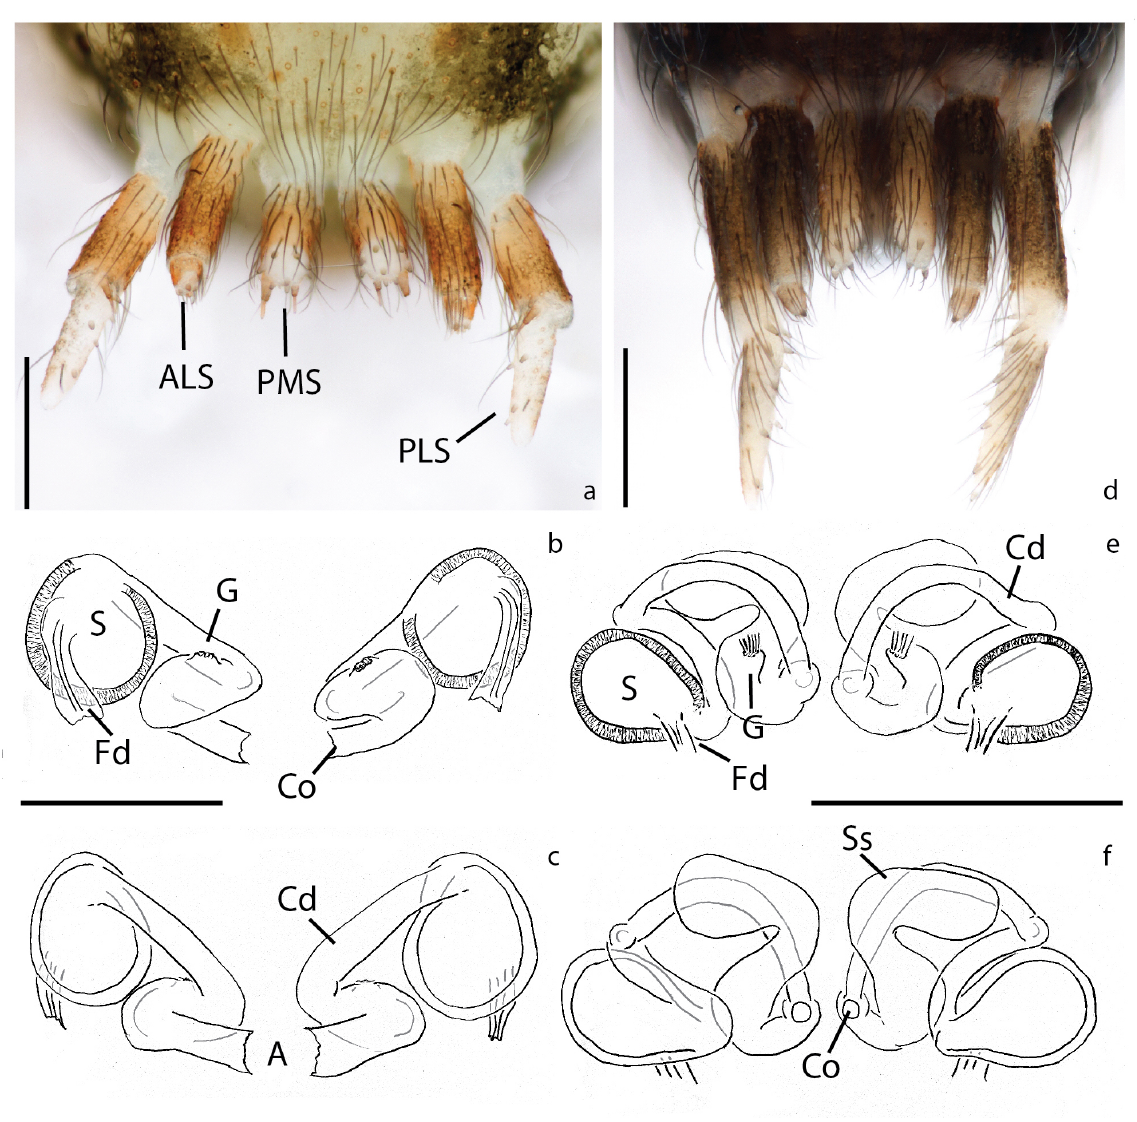
Fig. 6. Female spinnerets and genitals. a–c . Hahnia ngai sp. nov., holotype (RMNH.ARA.18415). a . Spinnerets, ventral view. b . Epigynum, cleared, dorsal view. c . Ventral view. d–f . Hahnia saccata Zhang, Li & Zheng, 2011 (RMNH.ARA.18412). d . Spinnerets, ventral view. e . Epigynum, cleared, dorsal view. f . Ventral view. Scale bars: a, d–f = 0.25 mm; b–c = 0.1